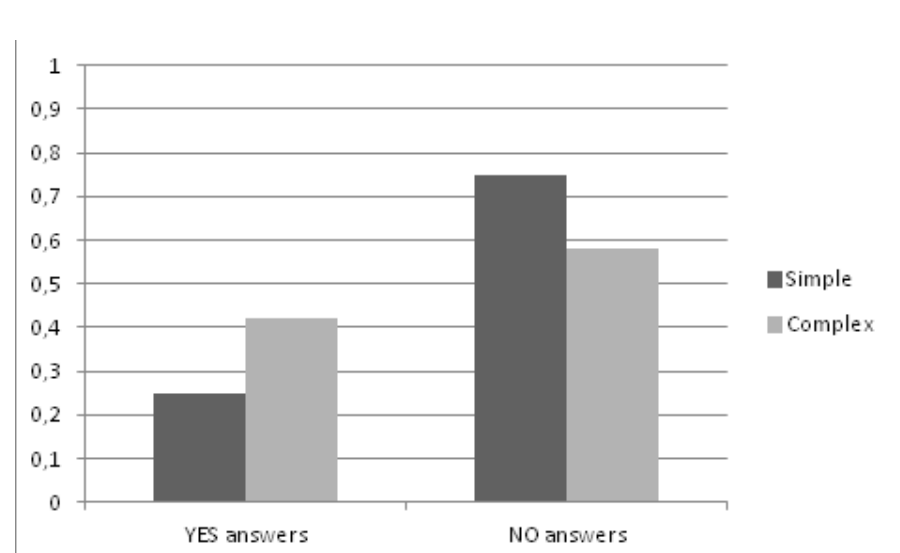
Figure 14 . Proportion between YES and NO answers for adjunct sentences: Effect of the syntactic complexity of the wh- phrase